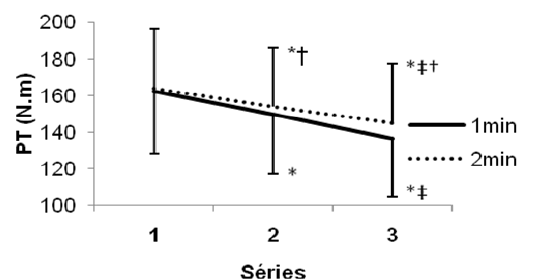
Figura 1. Pico de Torque (PT) a 60°/s nas três séries com um e dois minutos (min) de intervalo de recuperação.